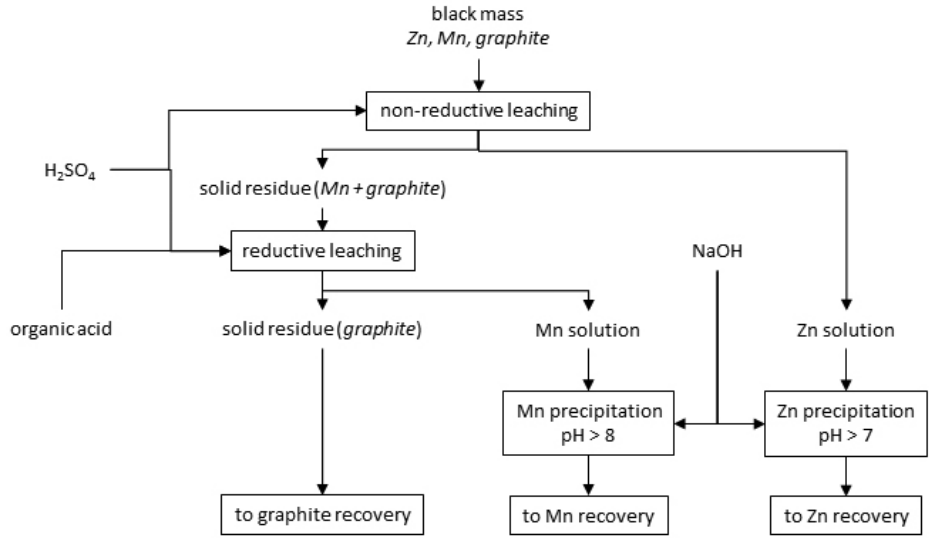
Figure 1. Proposal of hydrometallurgical treatment by selective leaching of alkaline batteries’ black mass for zinc, manganese and graphite recovery.